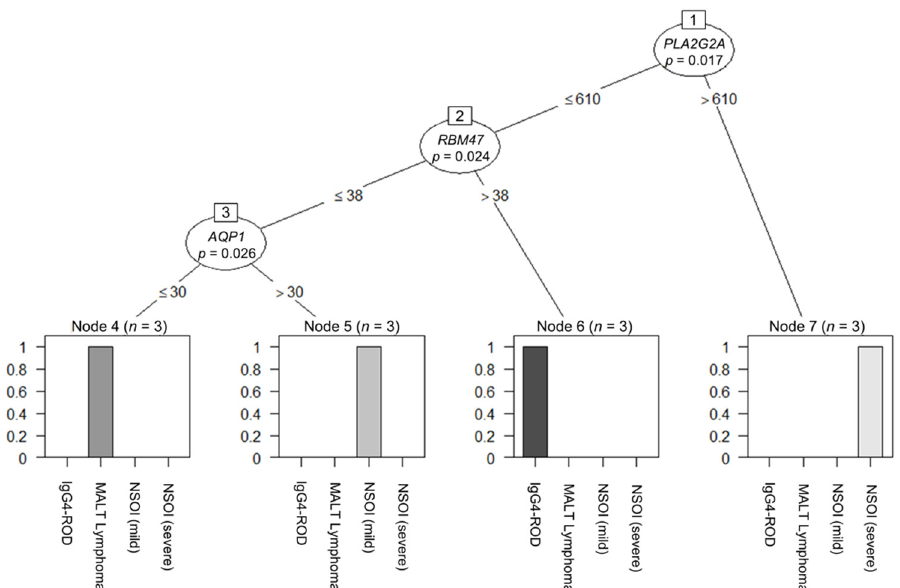
Figure 3. Decision-tree-based analysis using the “conditional inference tree” (CIT) machine learning algorithm regarding the different groups revealed a three-tier system based on (1) PLA2G2A ( p = 0.017), (2) RBM47 ( p = 0.024), and (3) AQP1 ( p = 0.026) expression levels.